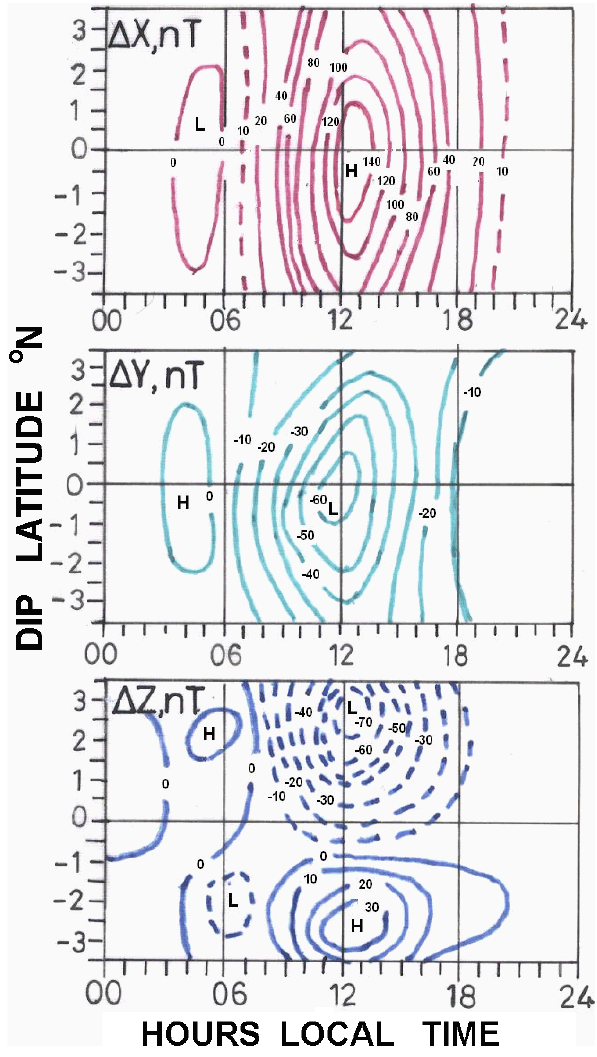
Fig. 8. Contours of the daily ranges 1X , 1Y and 1Z on the grid dip latitude versus local time averaged for all quiet days.